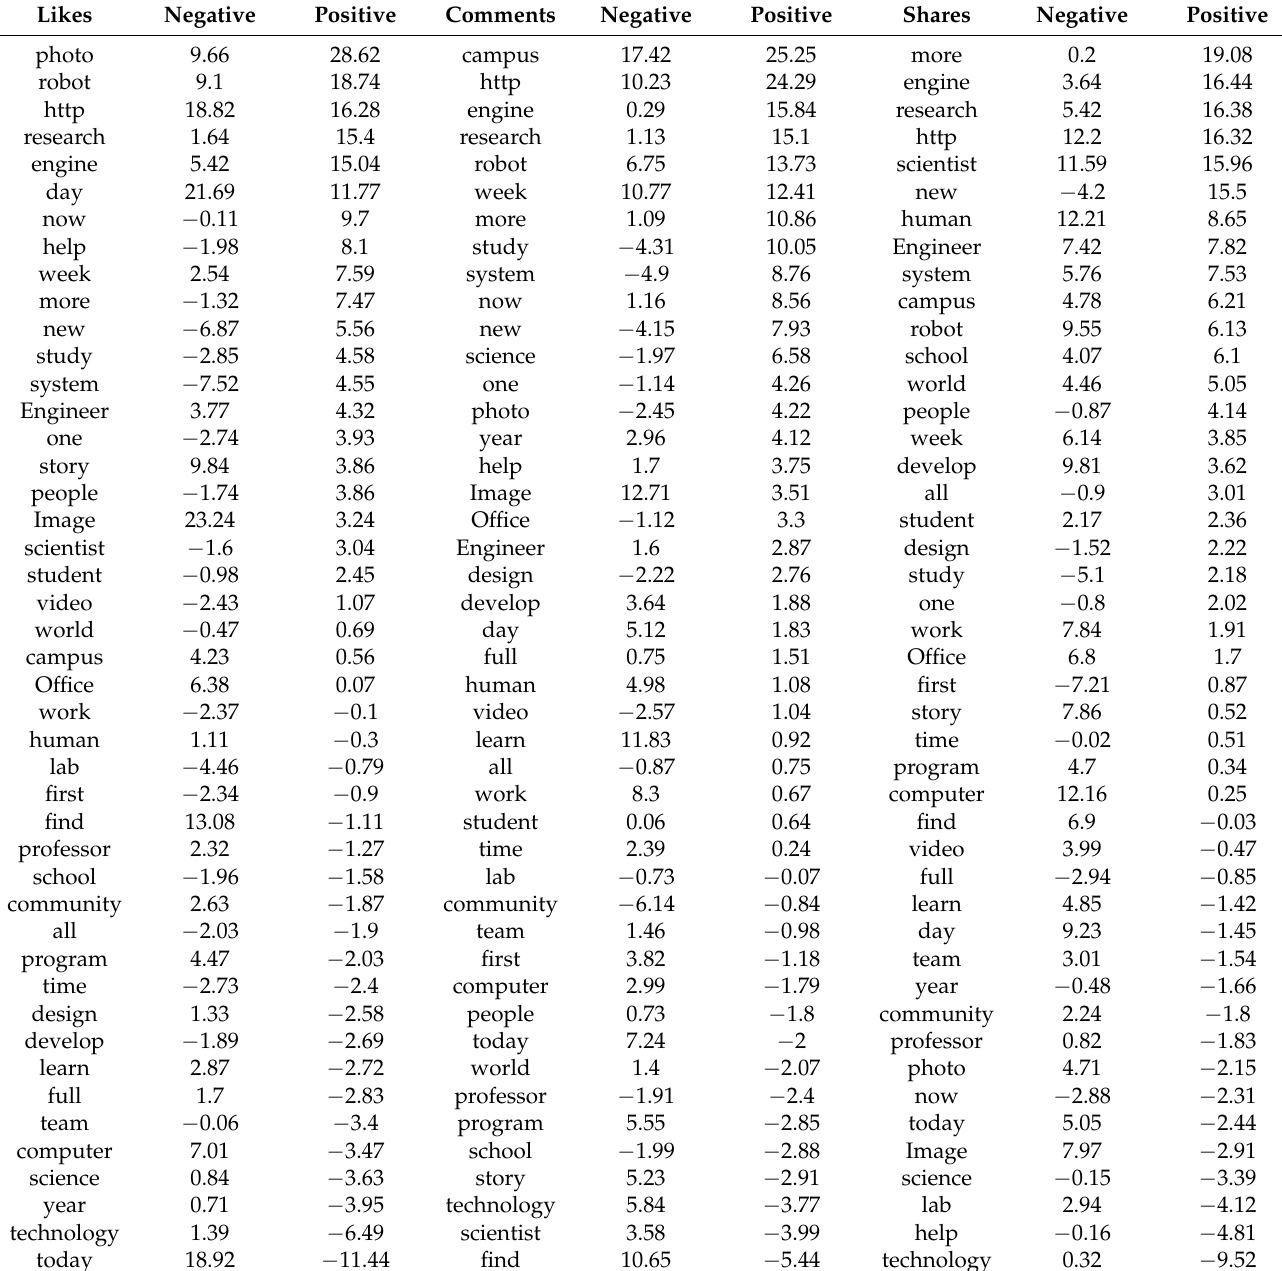
Table A2. Negative and positive clues (Massachusetts Institute of